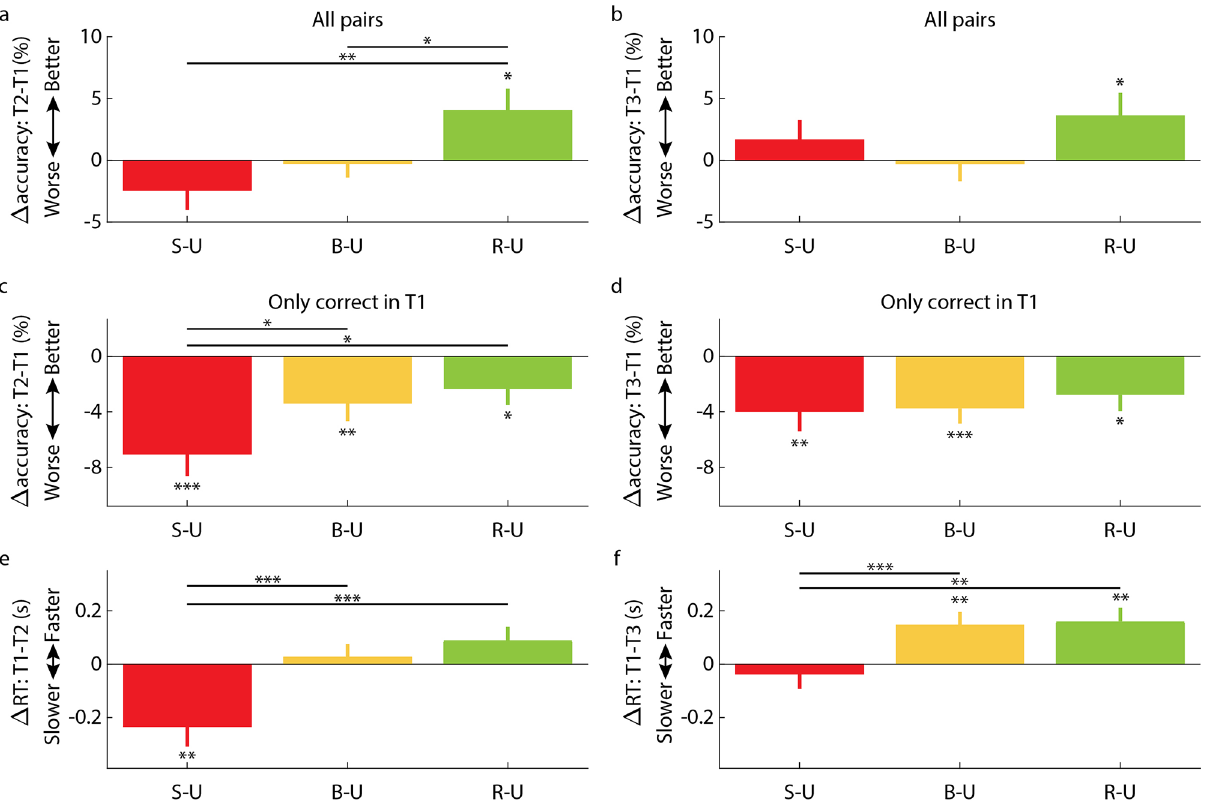
Figure 2. No-think and think manipulations effectively influenced memory retrieval. ( a ) Change in recall accuracy from T1 (pre-sleep) to T2 (immediately after sleep) for the three conditions with no corresponding cues during sleep (i.e., a suppression condition, a baseline condition, and a response condition). ( b ) Change in recall accuracy from T1 (pre-sleep) to T3 (the next day) for the three conditions with no corresponding cues during sleep. ( c , d ) These analyses repeated considering only pairs that were correctly recalled in T1 (i.e., the conditionalized dataset). ( e ) Change in RT from T1 to T2 for the same three conditions. ( f ) Change in RT from T1 to T3 for the same three conditions. Values reflect coefficient estimates produced by the linear model; error bars denote standard error of the mean for coefficients. * p < 0.05; ** p < 0.01; *** p < 0.001. S-U suppression– uncued, B-U baseline–uncued, R-U